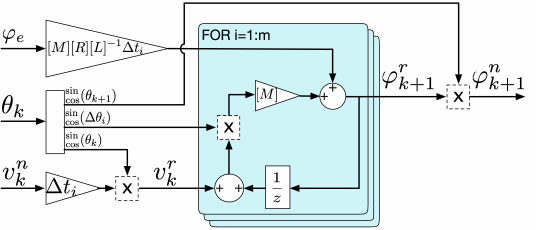
Figure A4. Discrete time model with fast rotation implementation and PM flux: